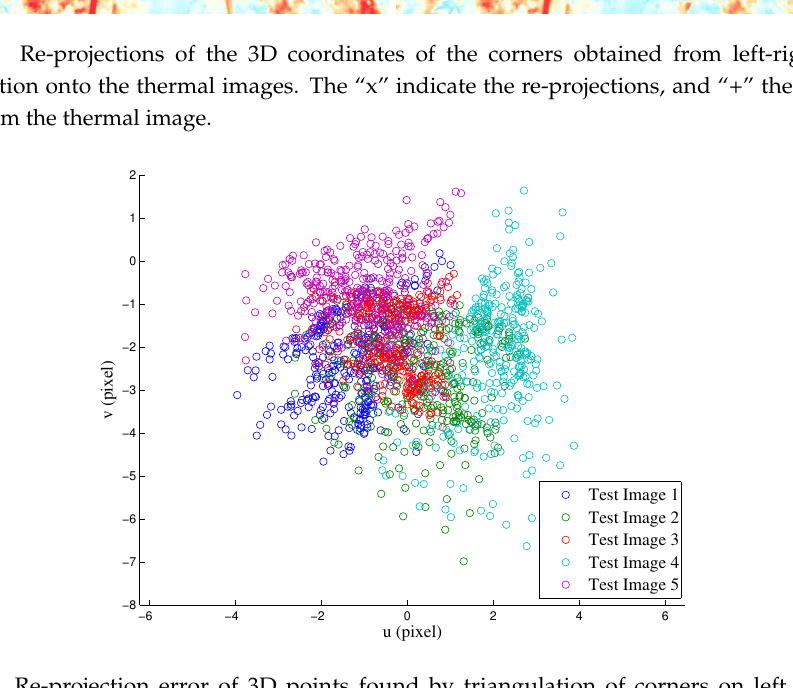
Figure 15. Re-projection error of 3D points found by triangulation of corners on left and right RGB